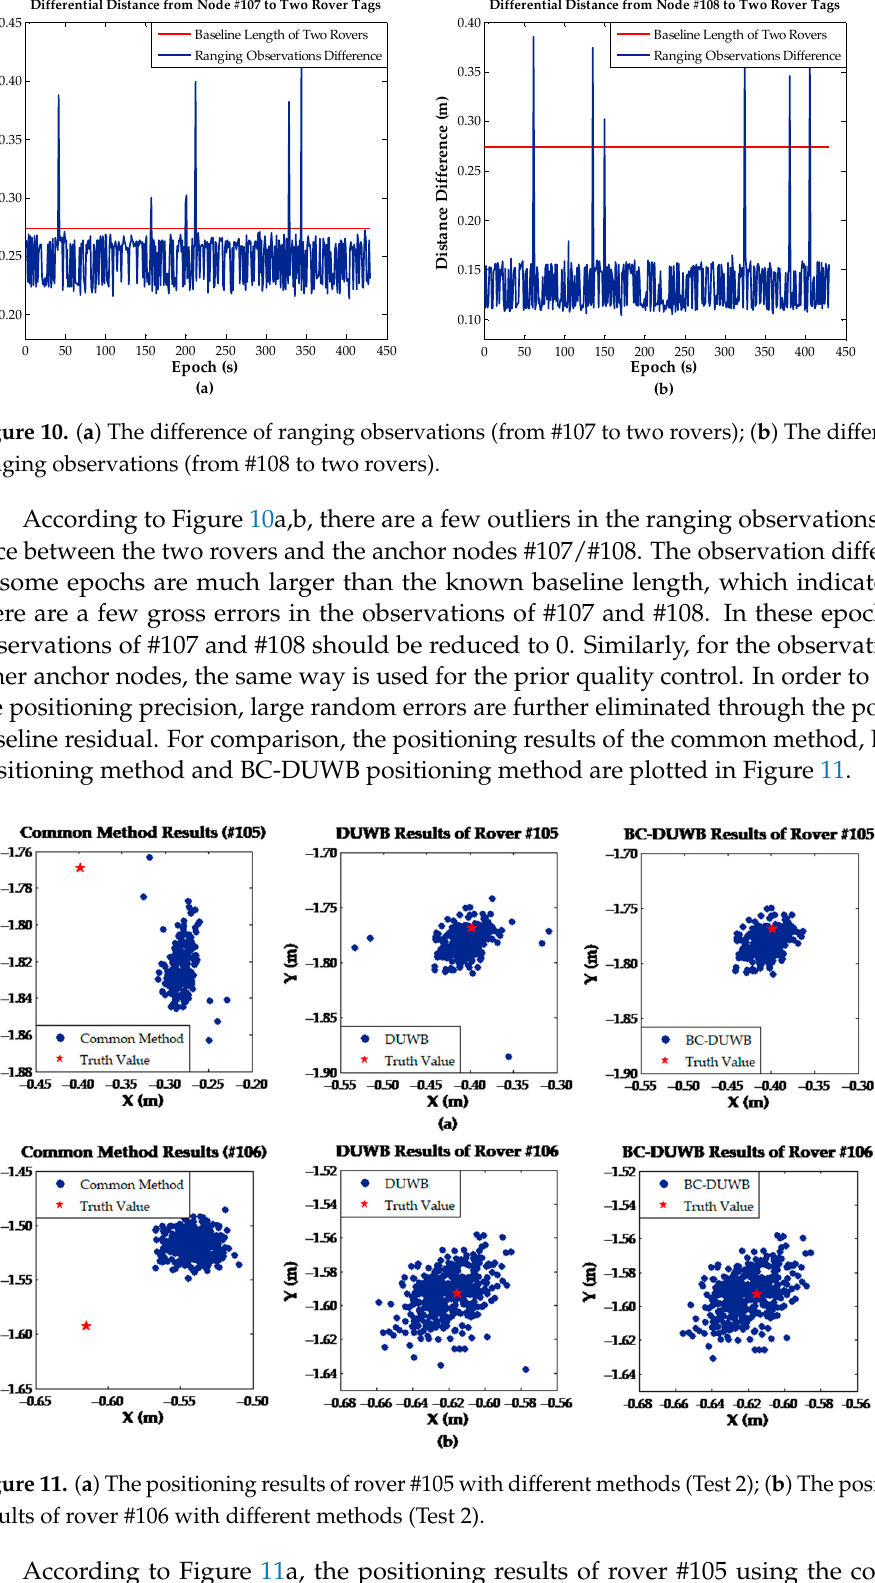
1.135 Table 7. STD and RMSE of Test 2 with Different Methods (cm).